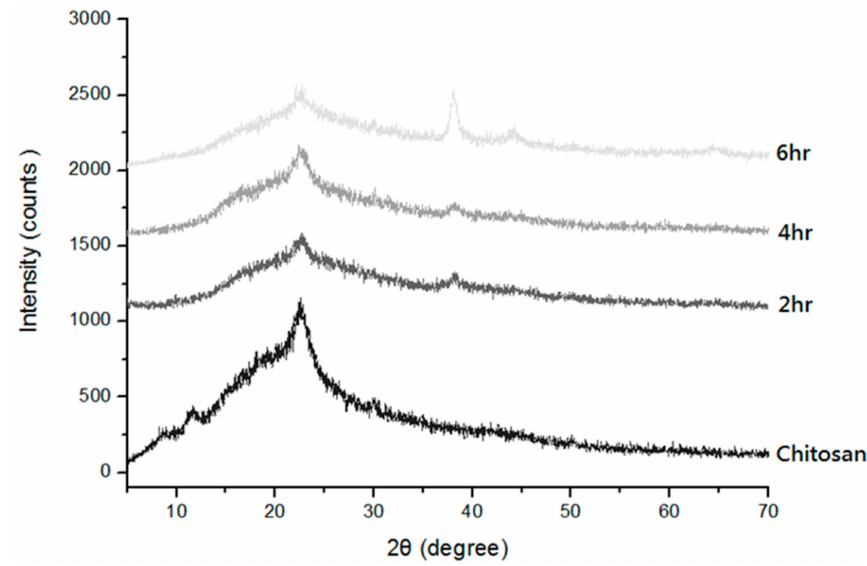
Figure 10. X-ray diffraction spectrum of chitosan/Ag membranes as related to reaction time.